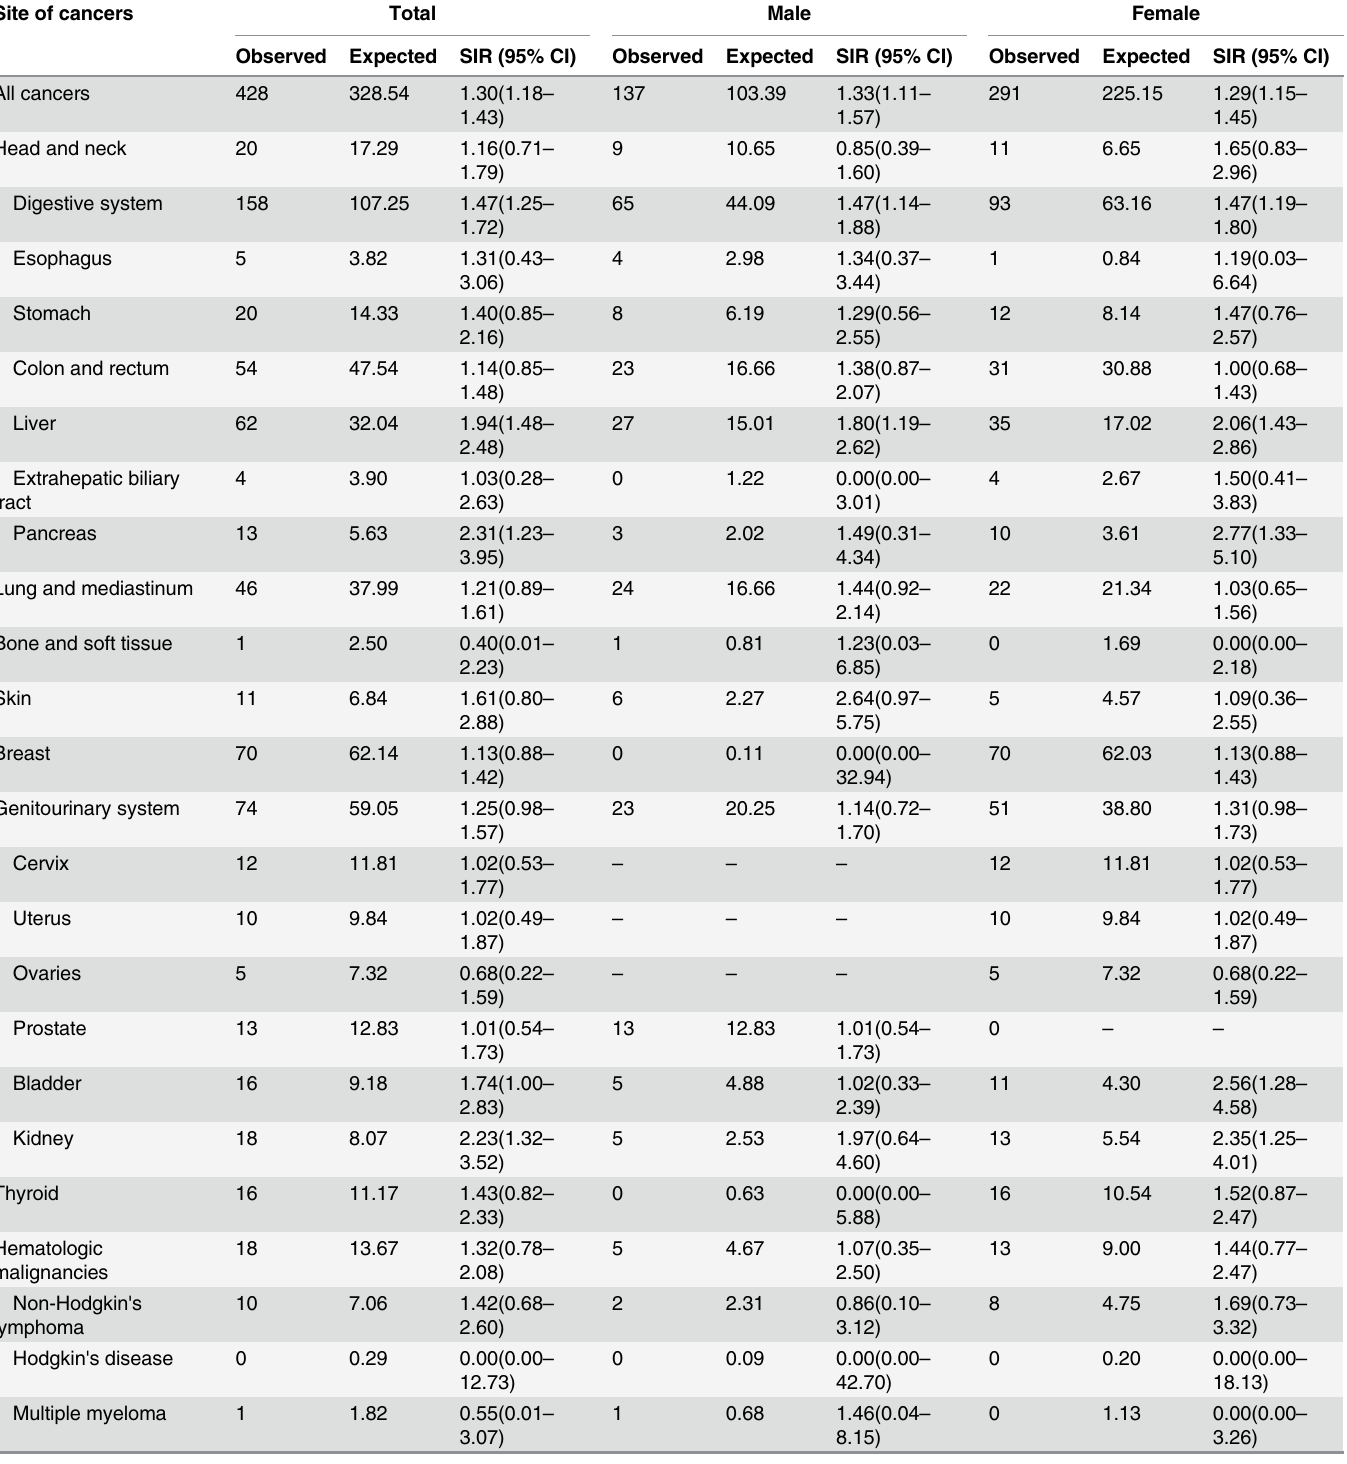
Table 4. SIRs of speci fi c cancer types among patients with iron de fi ciency anemia (IDA) after excluding the fi rst fi ve years of observation post